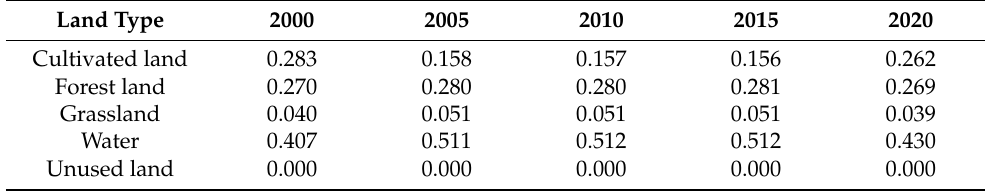
Table 4. Sensitivity test of the revised ESV coefficients in the Nanjing metropolitan area.